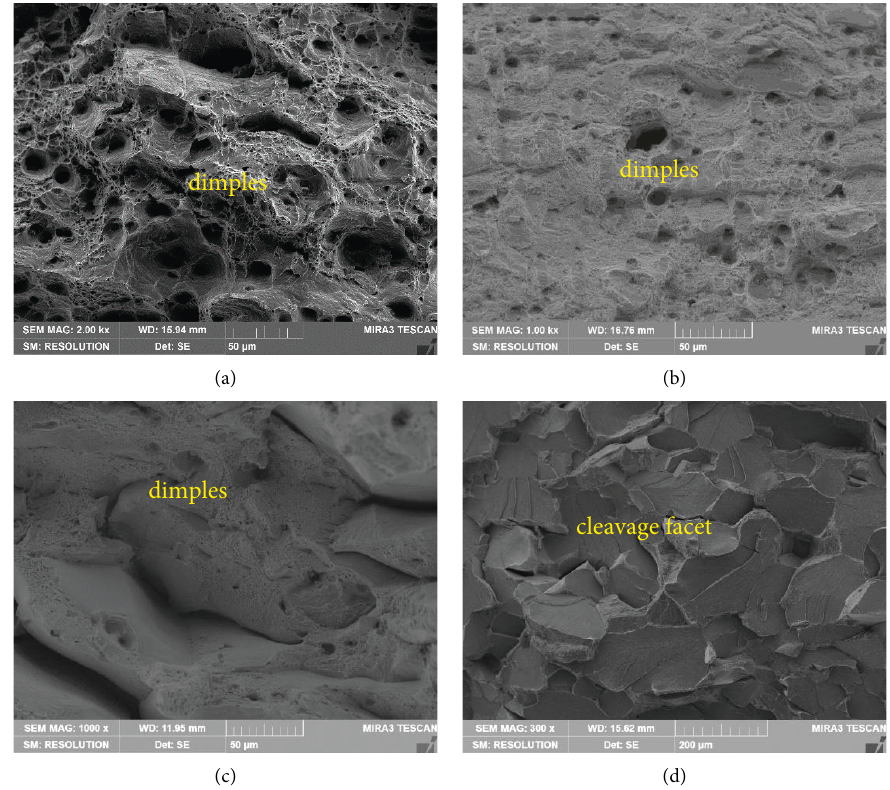
Figure 10: Tensile fracture morphology of samples after fire stimulation treatment: (a) solution treated, (b) 600 ° C × 4h, (c) 800 ° C × 1h, (d) 800 ° C ×